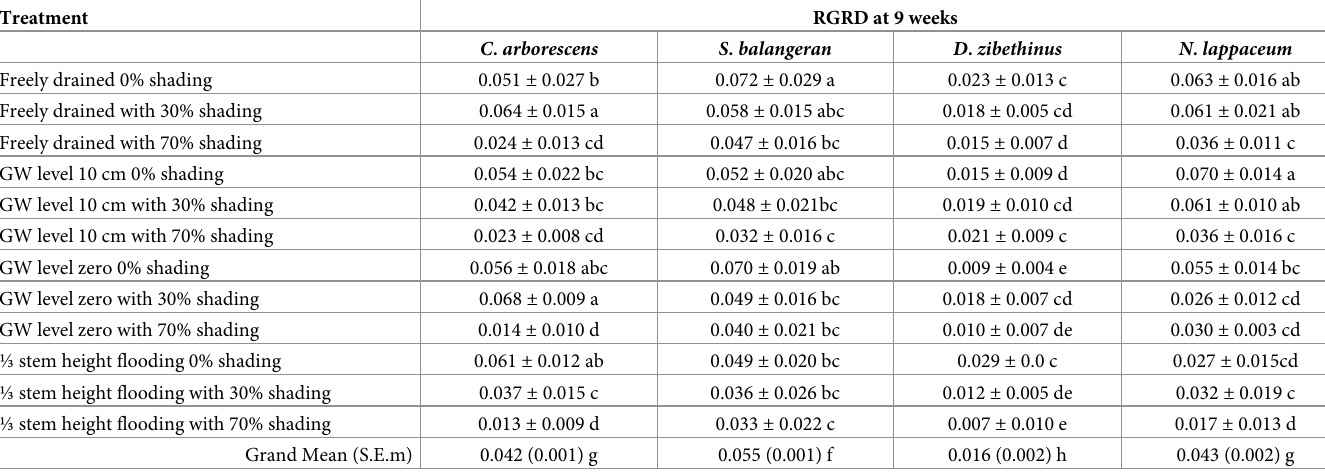
Table 3. RGRD of C . arborescens , S . balangeran , D . zibethinus and N . lappaceum at 9 weeks after planting in the shading and inundation treatments.